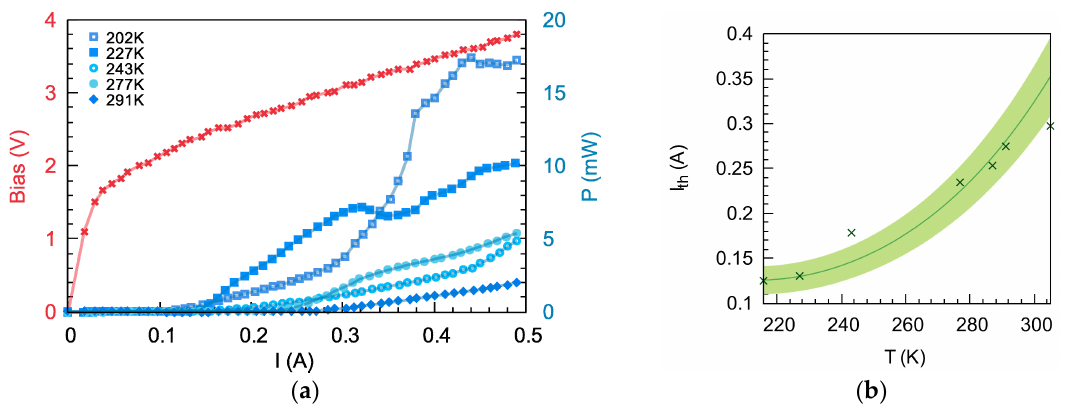
Figure 2. Laser operation. ( a ) Voltage bias (crosses) and emitted power versus injected current. The I-V curve is measured at T room = 291 K, while I-P for T is in the range 202–291 K. At room temperature the laser has a threshold of I th = 0.274 A, a turn on voltage of 1.8 V; ( b ) Measured (crosses) and calculated (continuous line) threshold current as a function of temperature. The error band around the calculated threshold corresponds to the uncertainty of the diode surface after the wet etching and cleaving processes.